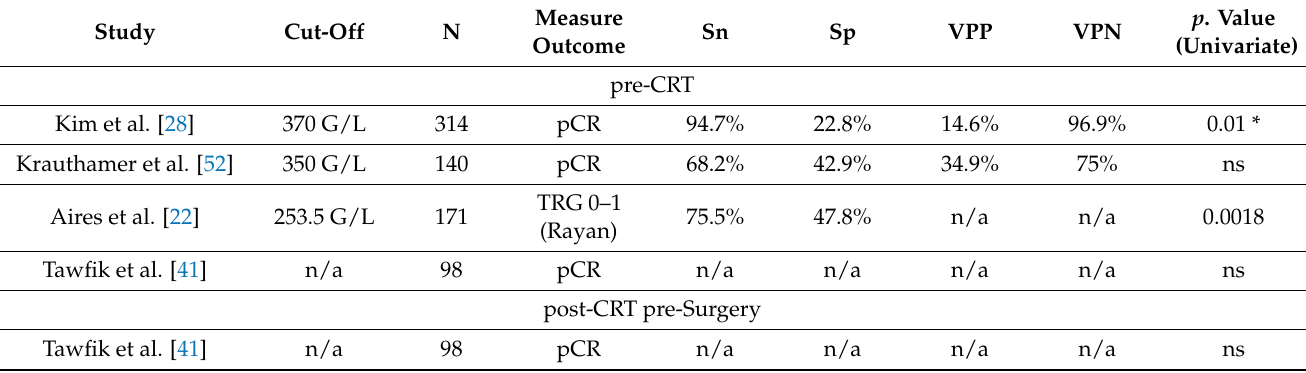
Table 2. Studies exploring thrombocytes level as a biomarker predictive of tumor regression following